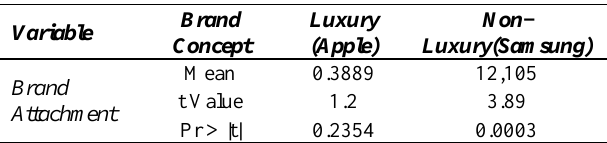
Table 1: Effect of downward brand extension on brand